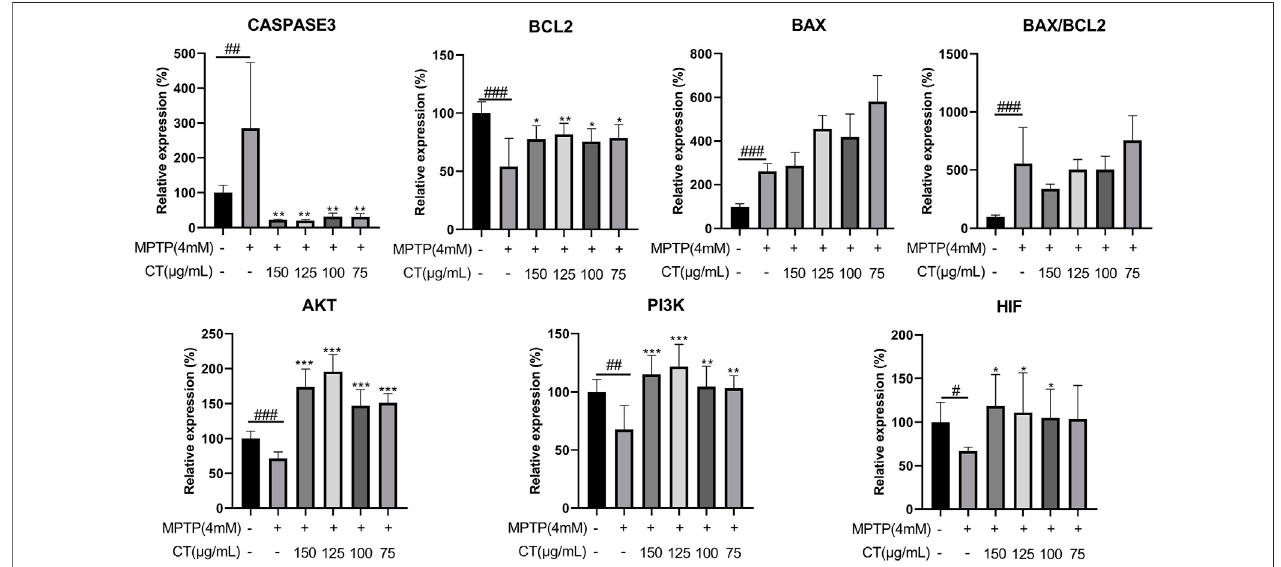
FIGURE 7 | Gene expression levels of key predicted targets in cells treated with the CT extract. Data were shown as mean ± SD ( n = 3). # p < 0.05, ## p < 0.01, ### p < 0.001 when compared with the control group. * p < 0.05, ** p < 0.01, *** p < 0.001 when compared with the MPTP-induced model group.